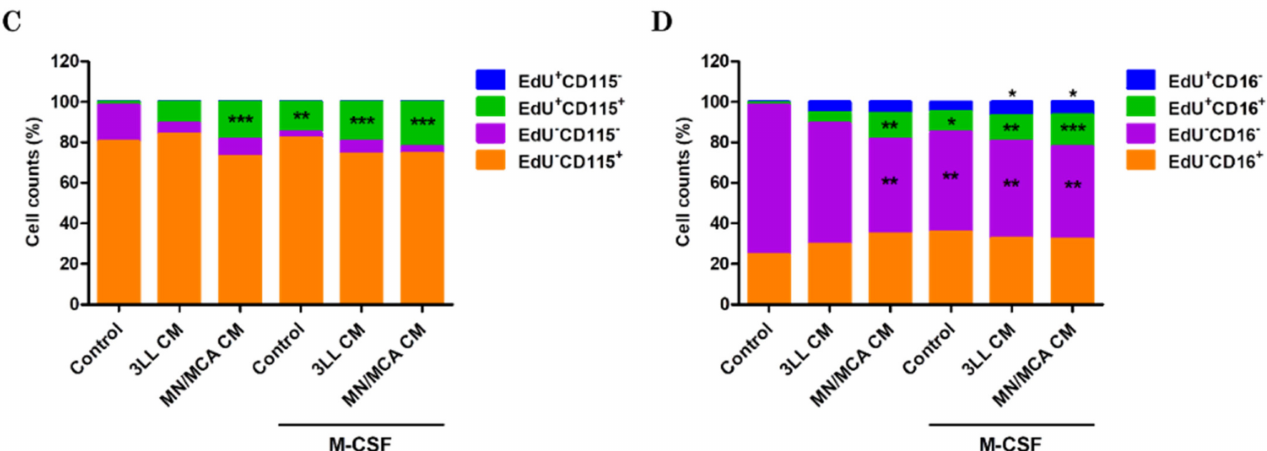
Figure 3. Tumor-conditioned media promote macrophage survival and proliferation. Bone marrow hematopoietic pro- genitor cells were collected and stimulated with M-CSF in the presence of 3LL or MN/MCA-conditioned media (CM) for 3 days. To some cultures PLX-3397 was also added. ( A ) Flow cytometry strategy to select the populations according to FSC x SSC firstly (left panel), then to exclude cell doublets (middle panel), and finally to separate non-proliferating (R3) and proliferating (R4) groups of cells (right panel). ( B ) On day 4 of culture, cells were stained with an EdU probe and analyzed by flow cytometry. ( C , D ) On day 4 of culture, cells were indeed stained with anti-CD115 or anti-CD16 antibodies to analyze proliferating and non-proliferating groups using flow cytometry. Graphs show EdU + (blue and green) and EdU − (purple and orange) cells investigated for CD115 (green and orange; panel C ) or CD16 (green and orange; panel D ) expression. n ≥ 3 independent experiments. *: p ≤ 0.05; **: p ≤ 0.01; ***: p ≤